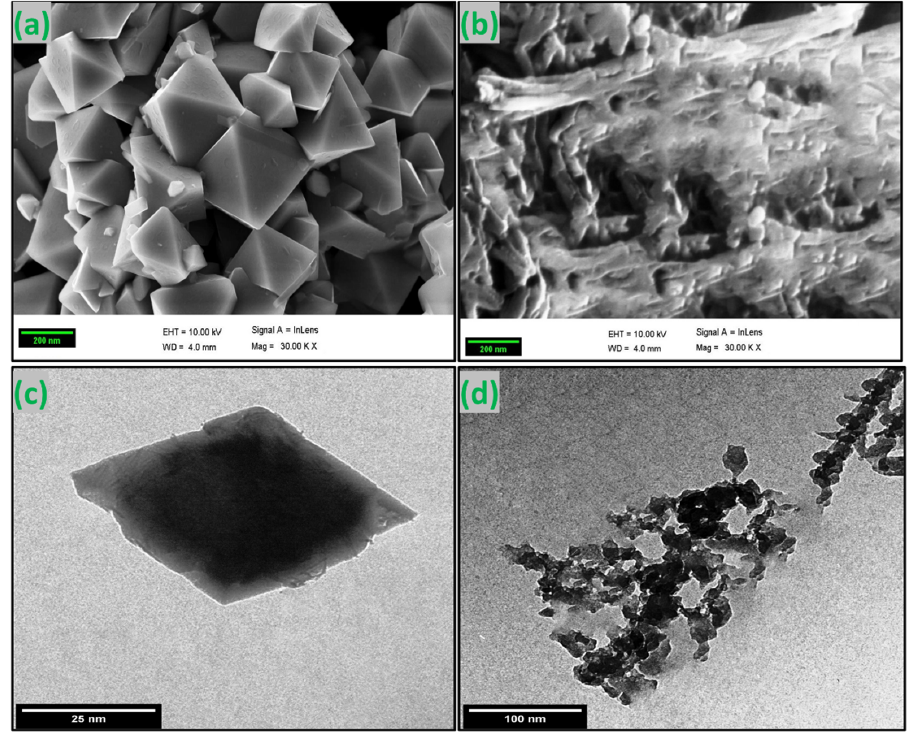
Figure 4. ( a , b ) SEM images of green synthesized CoFe 2 O 4 nanoparticles and CoFe 2 O 4 /Ca ‐ Alg nanocomposite, respectively; ( c , d ) TEM images of the green synthesized CoFe 2 O 4 nanoparticles and CoFe 2 O 4 /Ca ‐ Alg nanocomposite, respectively.